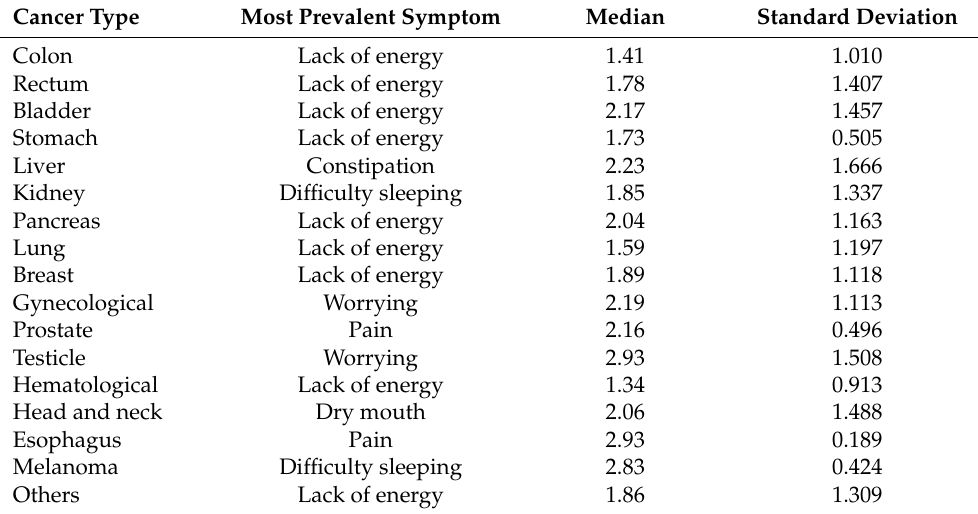
Table 2. Most prevalent symptom in each type of cancer.